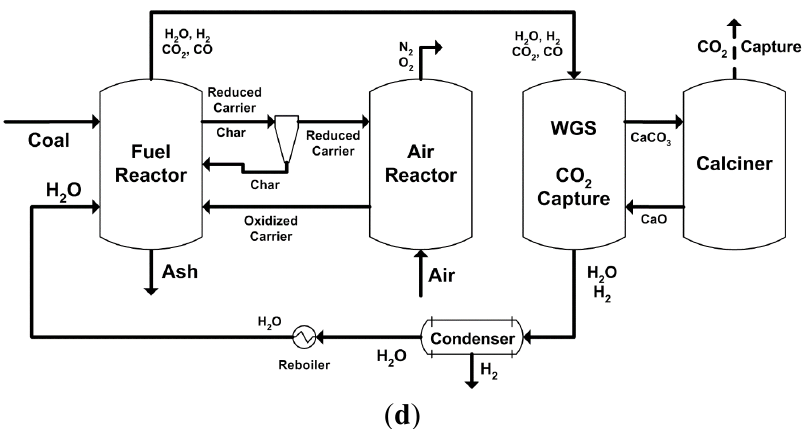
Figure 3. Major reaction processes of solid fuels in chemical-looping gasification: ( a ) Iron-based syngas chemical-looping (SCL); ( b ) Calcium-based SCL and ( c ) Direct chemical-looping (DCL); and ( d ) DCL with WGS and CO 2 capture